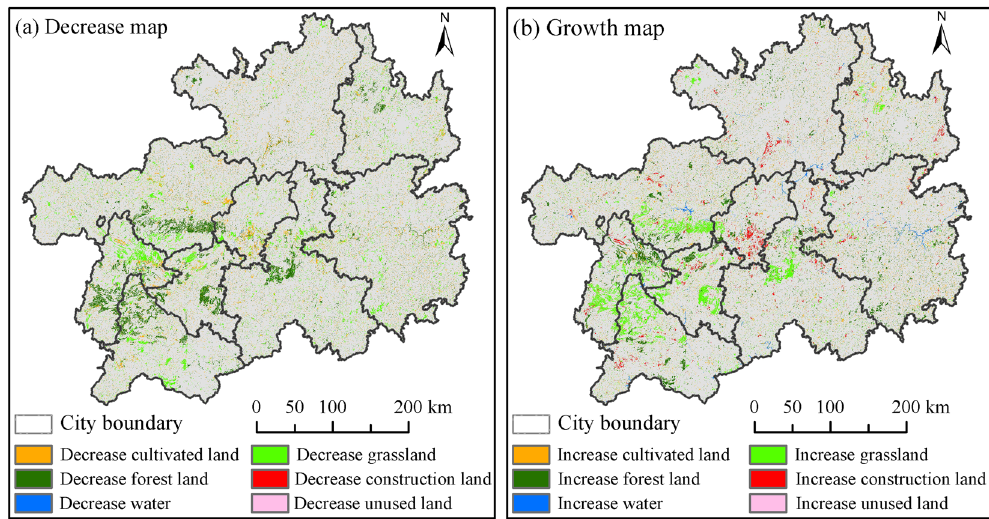
Figure 2. Maps showing the variations in land-use changes from 1980 to 2018 in Guizhou Province.